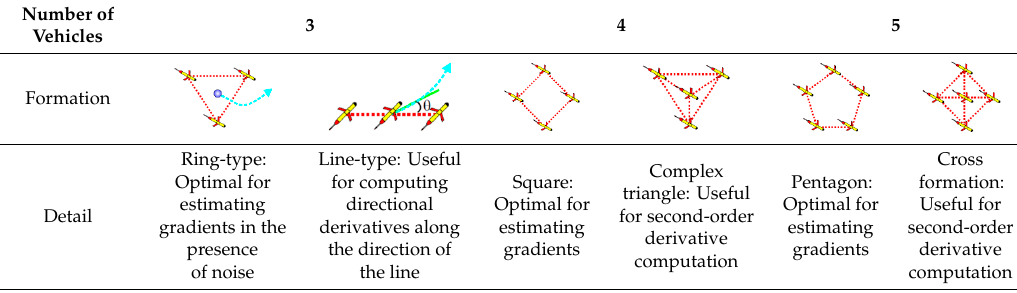
Table 15. A variety of configurations for a fleet of gliders in accordance with its number involved [18]. Number of Vehicles